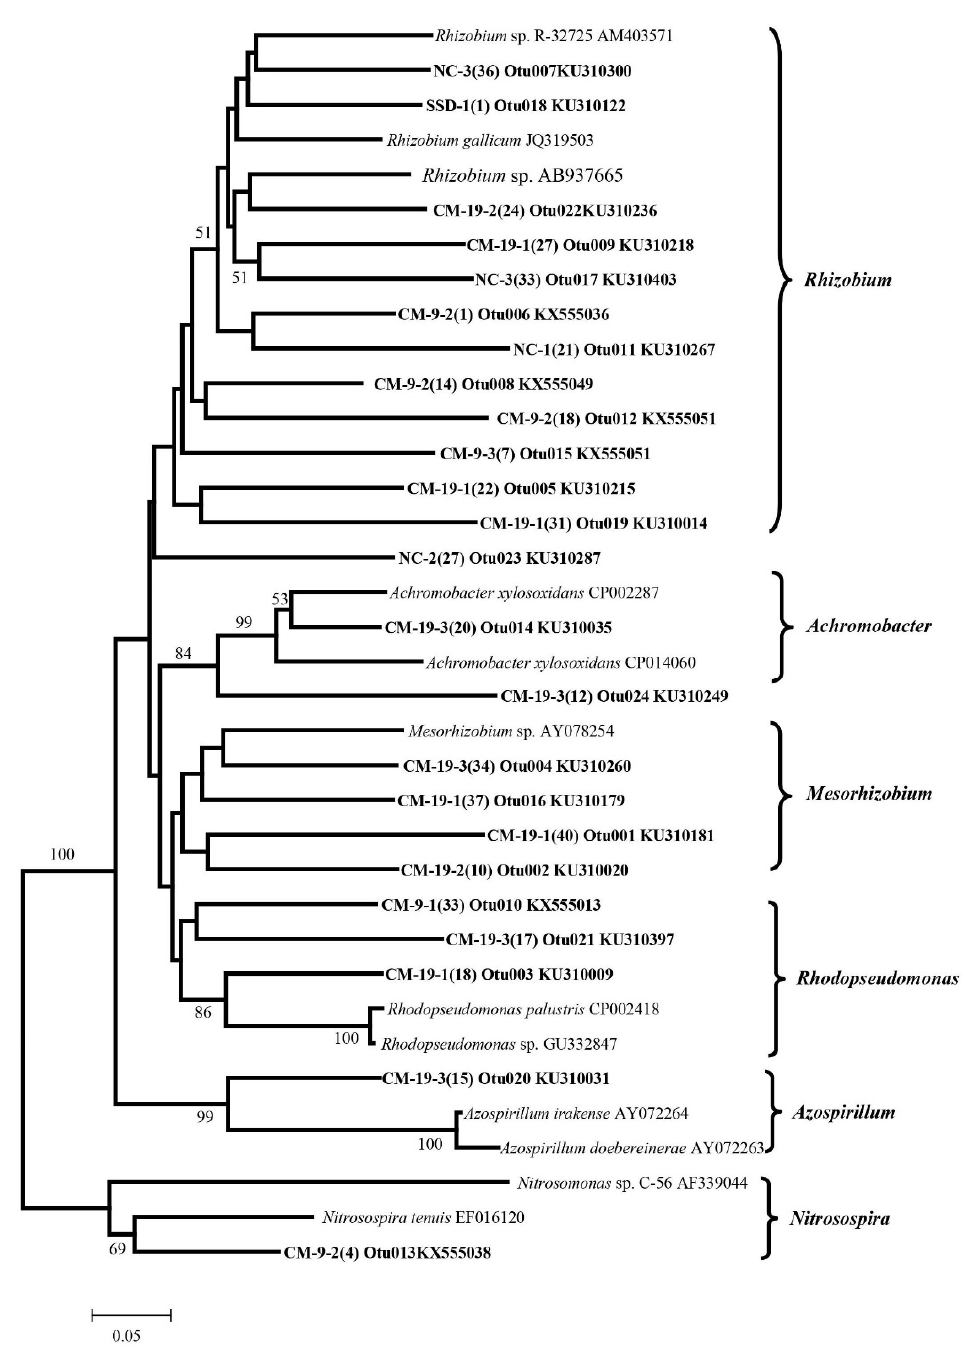
Figure 4. Phylogenetic distribution of 24 representative OTUs of the nirK gene. Tree was constructed by the sequences obtained from sand dune sampling sites and additional their closely matched sequences from GenBank.